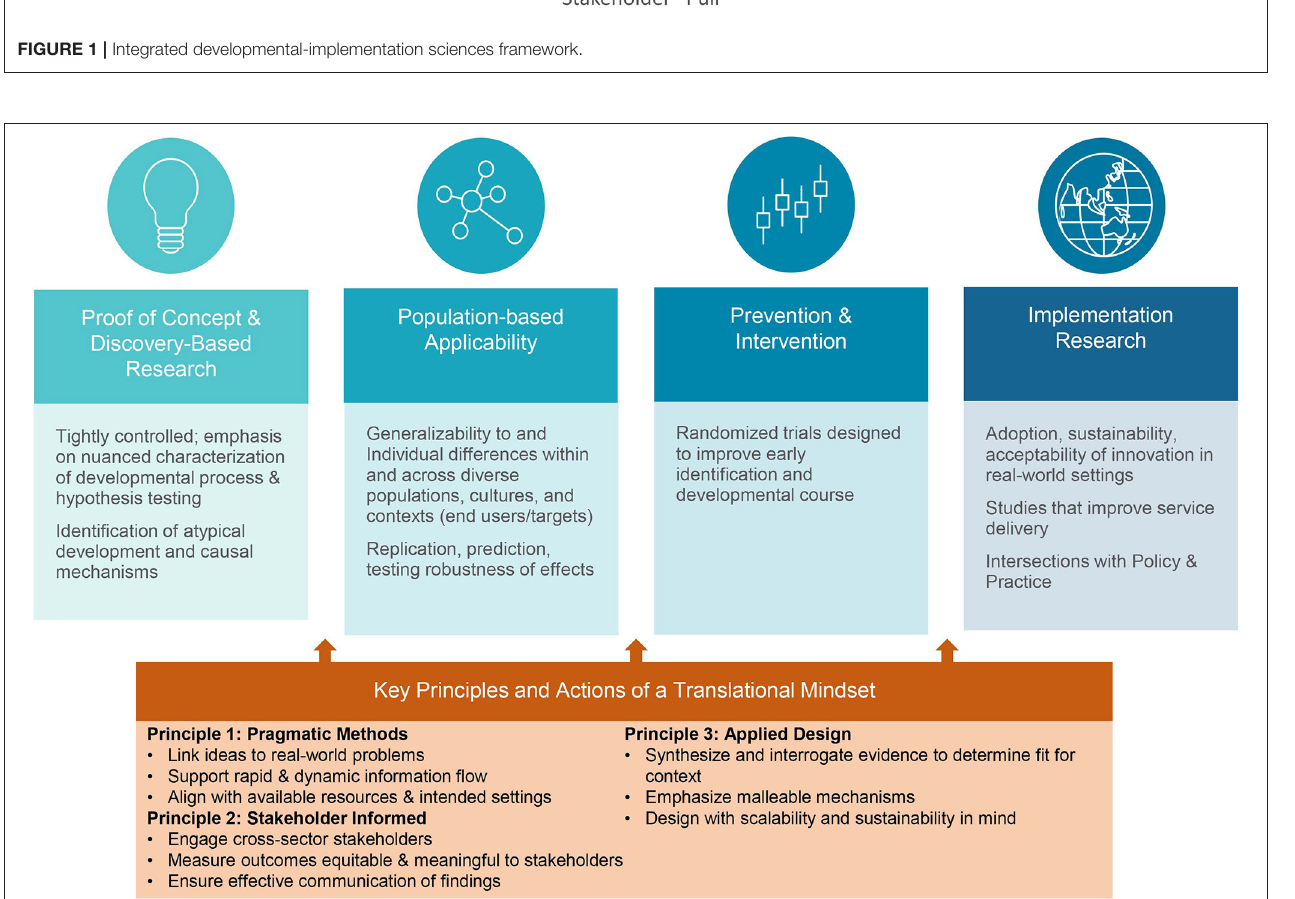
Frontiers in Public Health |